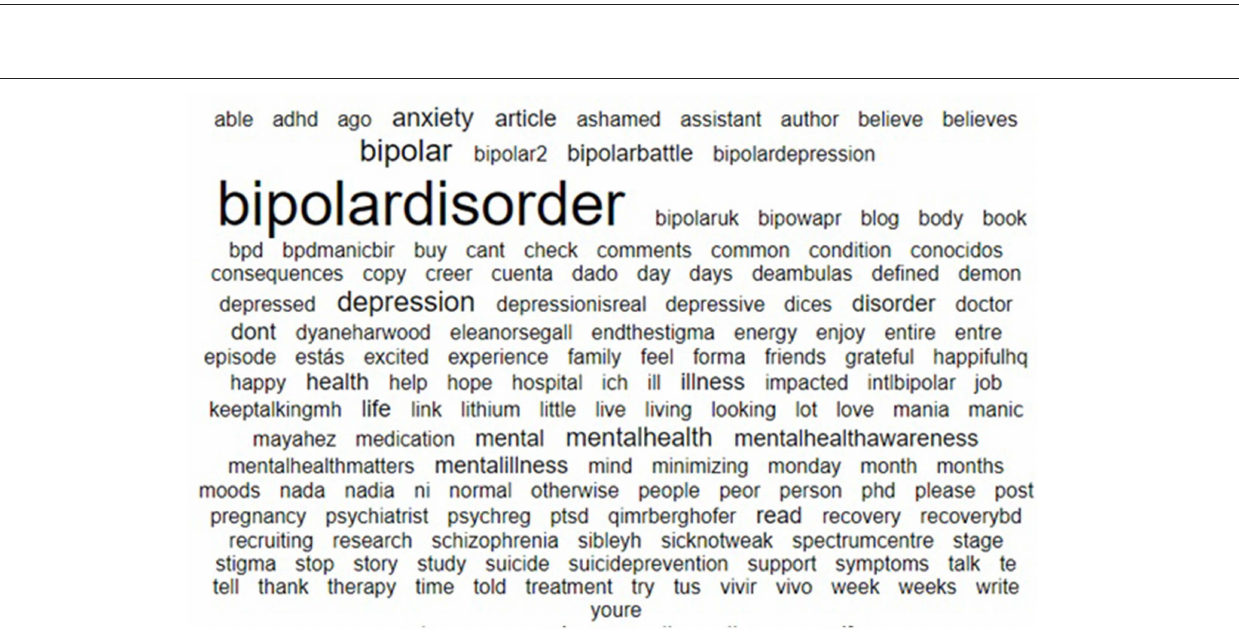
FIGURE A1 | #Bipolar Hashtag Cloud of Census Tweets.